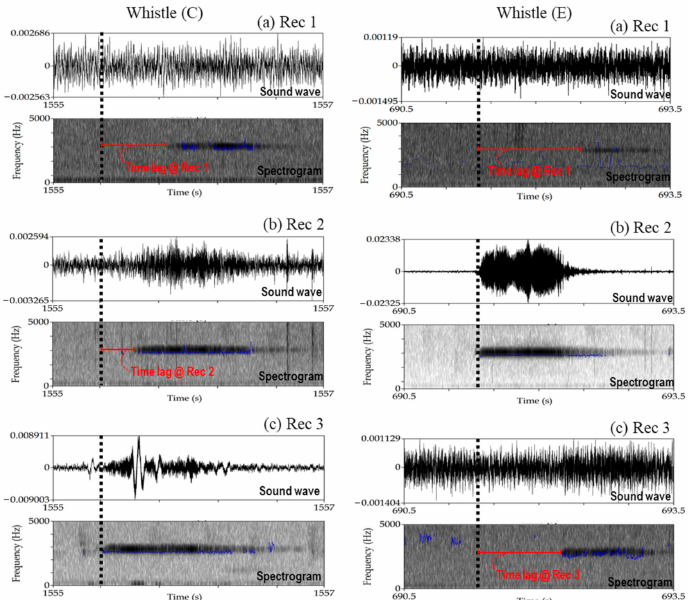
Figure 8. Sound waves and spectrogram of sound recordings from whistle C and whistle E at ( a ) Rec 1, ( b ) Rec 2, and ( c ) Rec 3, during the validation of the Oze Marshland Experiment. The locations of both whistles are shown in Figure 6b. Images were generated using Praat